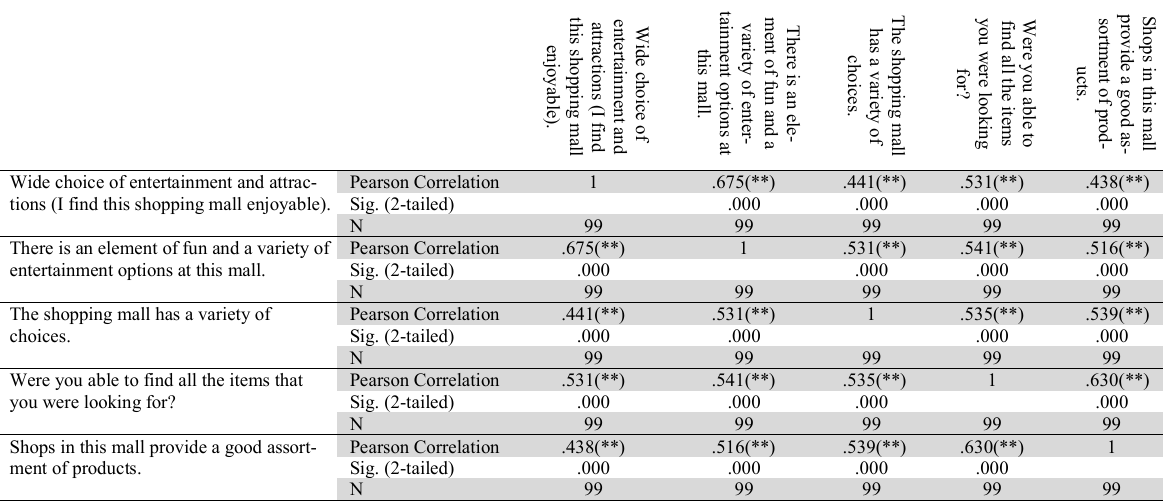
Correlation with Wide Choice of Entertainment and Attractions